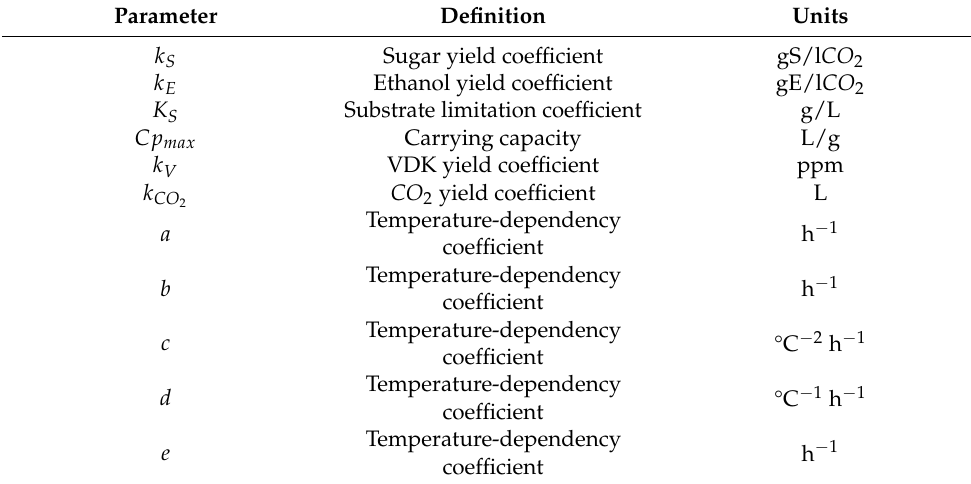
Table A2. Parameter nomenclature list for carbon dioxide